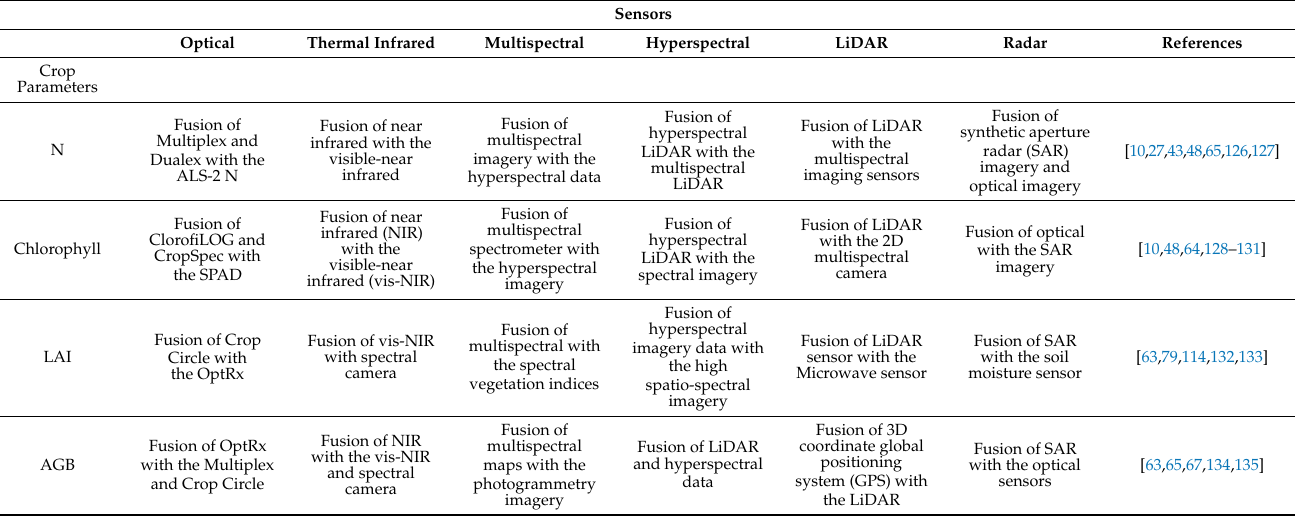
Table 1. Different sensors fusion methods for crop parameter